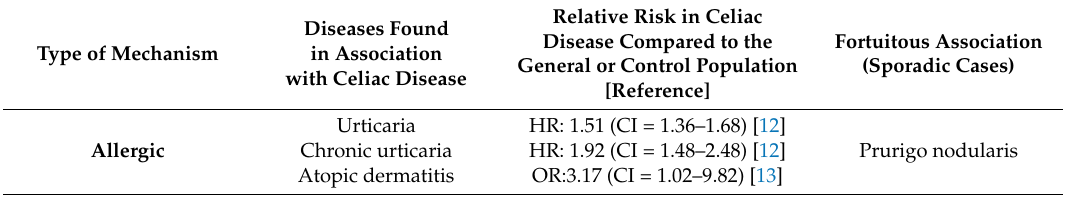
Table 1. Strength of evidence for the association between celiac disease and skin